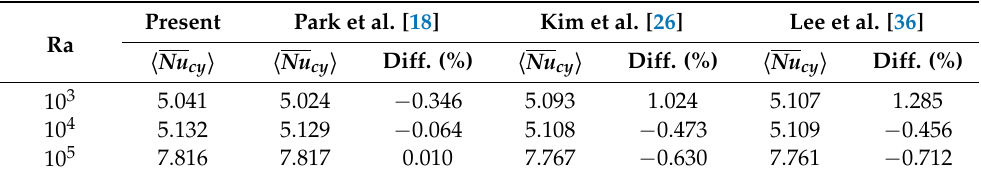
Table 1. Comparison of surface-averaged Nusselt number at hot wall from this study with those of previous numerical